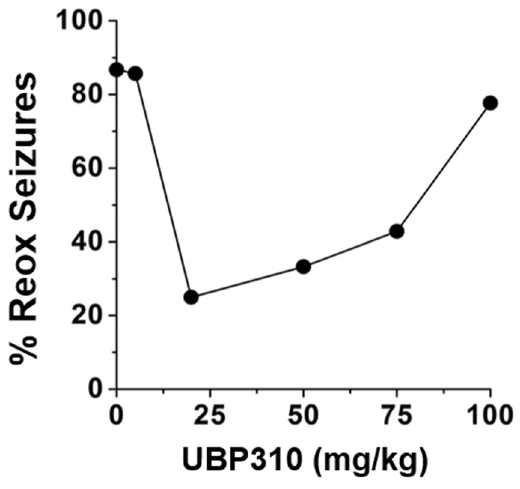
Figure 2. A dose response curve to UBP310 in neonatal P7–9 mice reveal a U-shaped curve. Nearly 90% of mice who did not receive UBP310 experienced a seizure during the reoxygenation period. This result was similar to those mice that received either 5 mg/kg (86%, n = 7) or 100 mg/kg (78%, n = 10). Following 50 and 75 mg/kg administration, reoxygenation seizures decreased to 33.3% ( n = 7) and 42.8% ( n = 7) of mice, respectively. A dose of 20 mg/kg achieved maximal results and reduced seizures by 75% ( n = 8). Therefore, subsequent experiments utilized 20 mg/kg UBP310. Note, UBP310 was administered subcutaneously 30 min prior to onset of hypoxia.